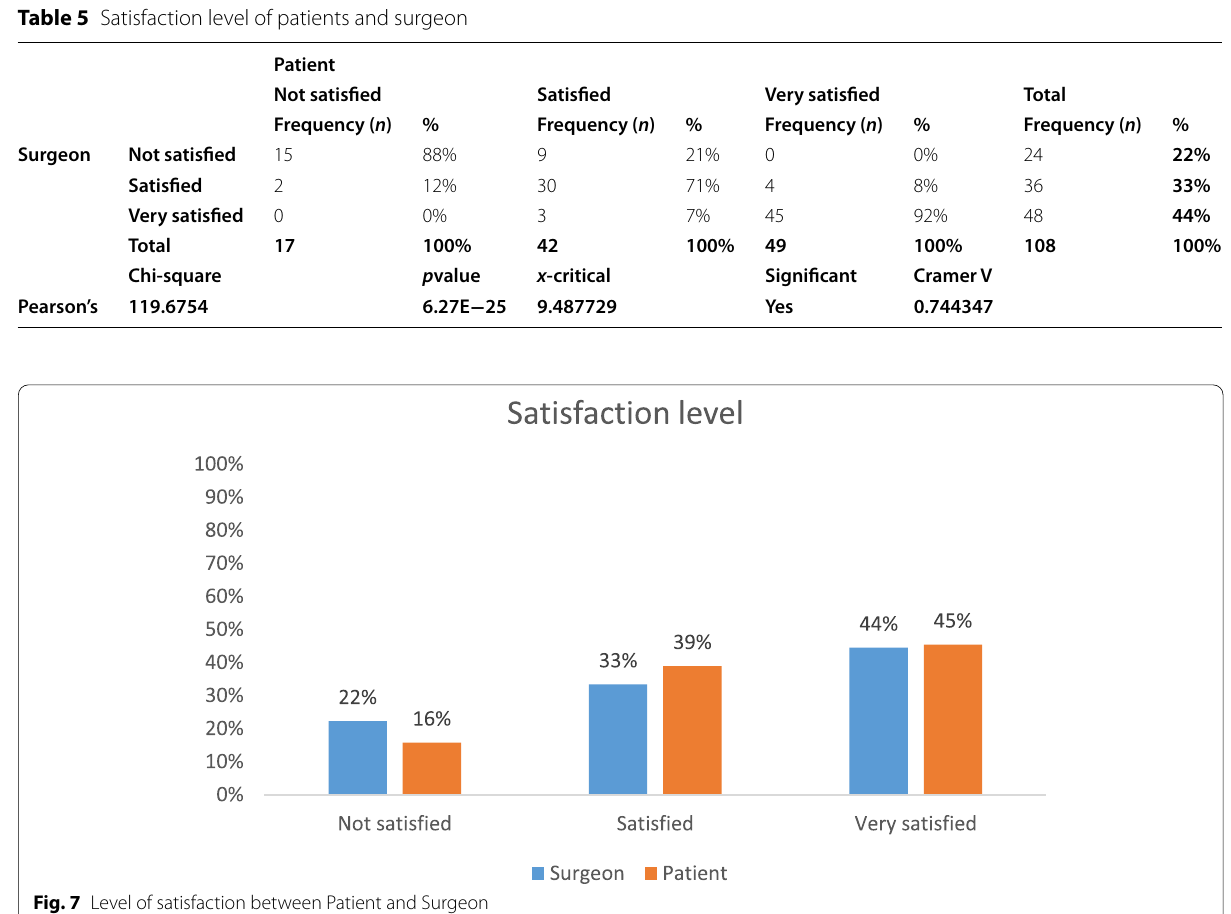
Fig. 7 Level of satisfaction between Patient and